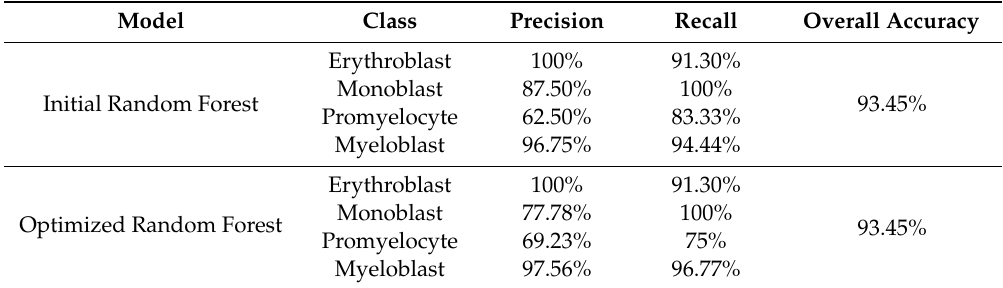
Table 5. Performance metrics for the initial and optimized random forest classifiers on each of the four immature leukocyte types.